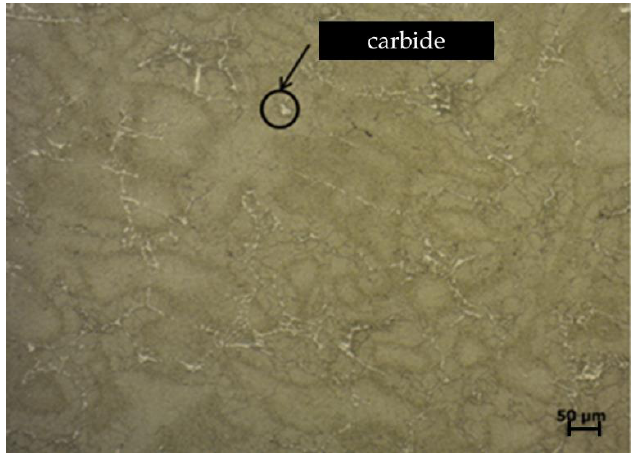
Figure 4. Carbides identified in the image obtained from optical microscopy in the stabilization heat treated condition.